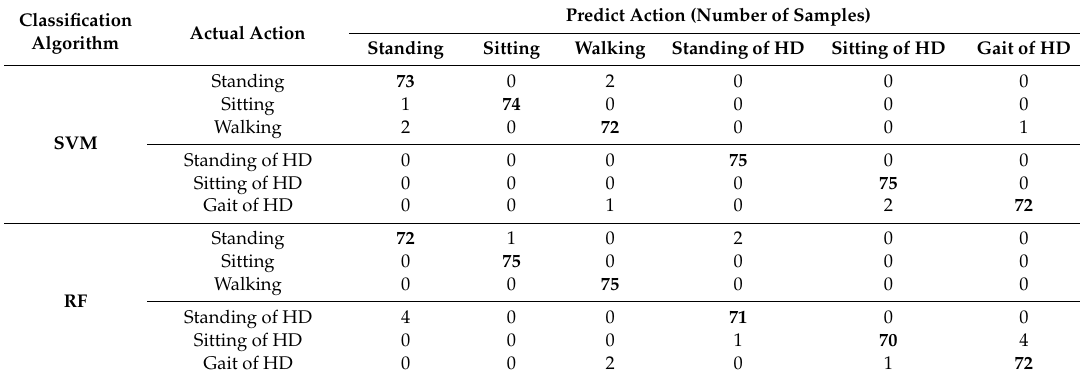
Table 4. Confusion matrix of classification algorithms.